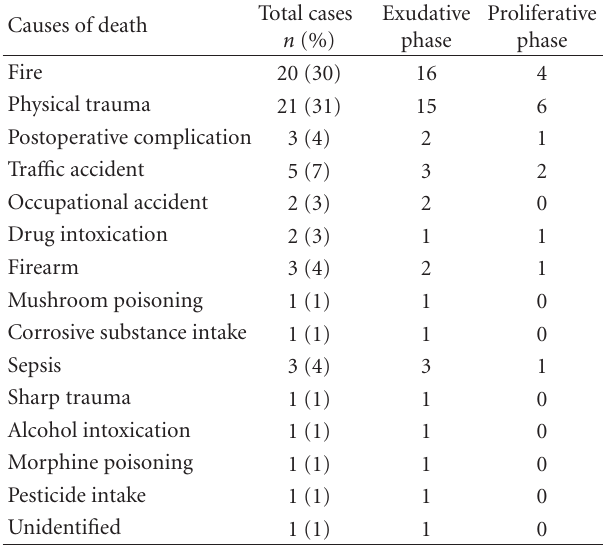
Table 2: Causes of death and di ff use alveolar damage (DAD) phase